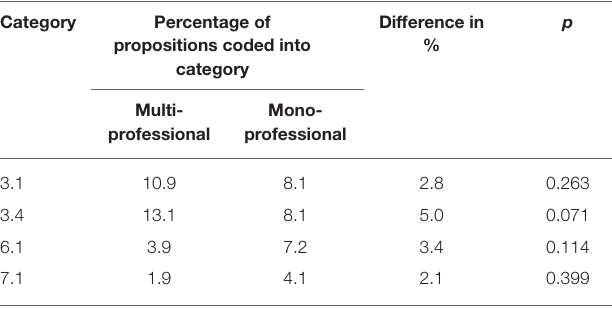
TABLE 4B | Teacher trainees in multi- compared to mono-professional teams at t2: relative frequency of propositions coded into the respective categories.